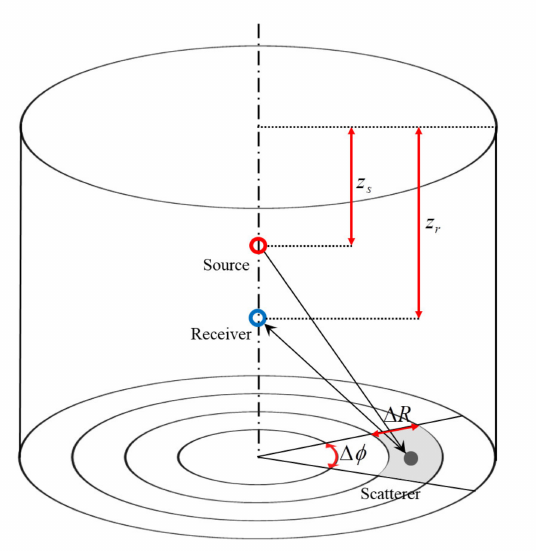
Figure 1. Schematic of the N × 2D bottom reverberation modeling of the depth-bistatic